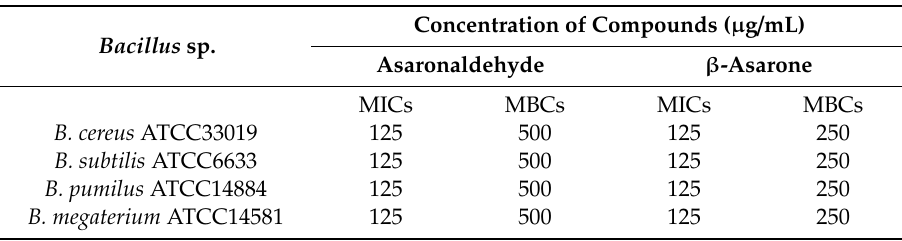
Table 2. Minimum inhibitory concentrations (MICs) and minimum bactericidal concentrations (MBCs) of β -asarone, and asaronaldehyde against B. cereus , B. subtilis , B. megaterium , and B. pumilus . Bacillus